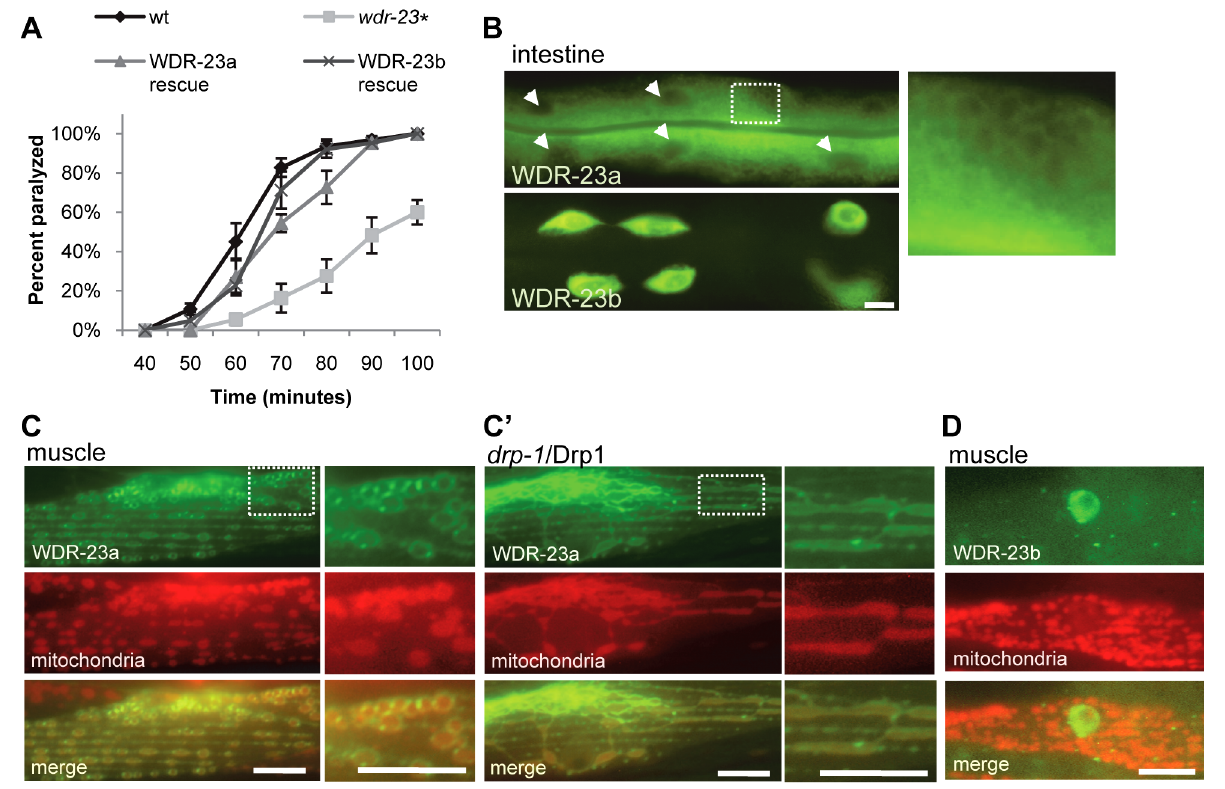
Figure 5. Subcellular localization and function of WDR-23 isoforms. (A) Rates of paralysis of the indicated strains on 1.0 mM aldicarb. WDR- 23a and WDR-23b rescues denote wdr-23 mutants expressing single copy transgenes containing wdr-23a or wdr-23b cDNA, respectively, driven by the endogenous wdr-23 promoter generated by Mos insertion. (B) Intestinal expression of WDR-23a-GFP and WDR-23b-GFP driven by the ges-1 promoter in a glo-1 background to reduce autofluorescence. Box highlights ring-like pattern of WDR-23a-GFP localization. Arrowheads indicate intestinal nuclei. (C) WDR-23a-GFP co-localization with the inverted outer mitochondrial membrane marker (INVOM-RFP) in muscle cells in wild type and drp-1 mutants. (D) WDR-23b-GFP localization in muscle cells; mitochondria are labeled with INVOM-RFP for reference (Scale bar represents 10 m m; Error bars indicate 6 SEM. * p , 0.05.)